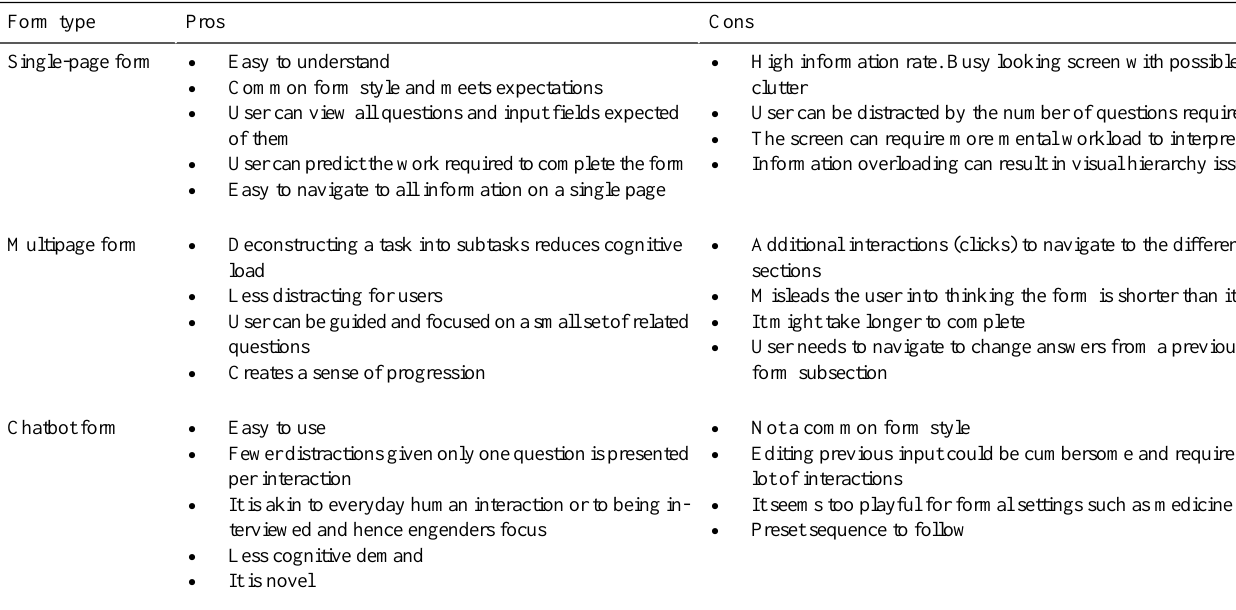
Table 1. Expected pros and cons of the three digital